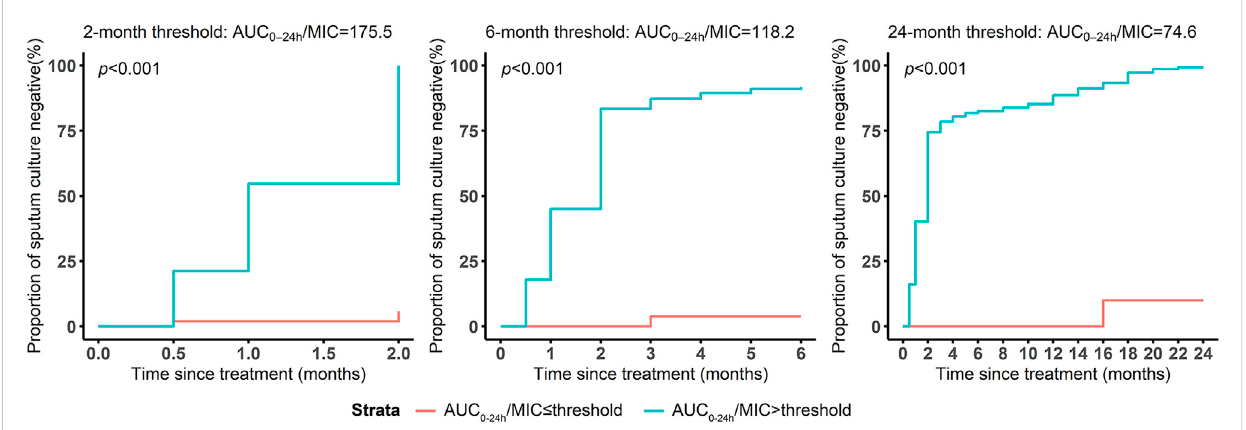
FIGURE 6 Survivalanalysisofmonths to sputum cultureconversiongrouped bythethresholds predictiveofdifferenttreatment outcomes.The survival curves wereillustratedtopresentthemonthstosputum conversion andcomparedusinglogrank testbetweentheparticipantsaboveandbelowthethresholds predictive of 2-/6- months sputum conversion and successful treatment outcome.